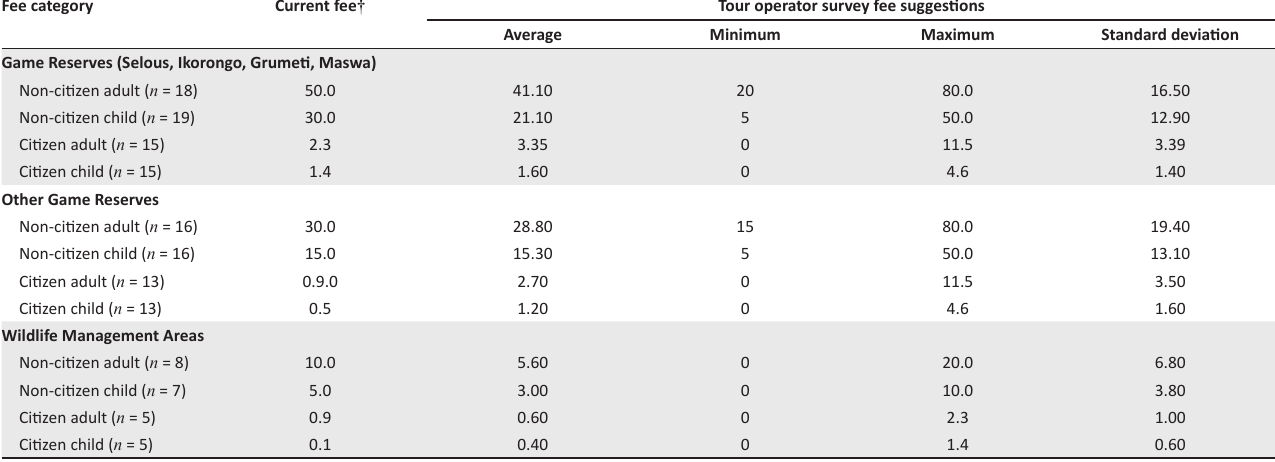
TABLE 3: Current and proposed entrance fees for Game Reserves and Wildlife Management Areas in USD equivalent values. Fee category Current fee † Tour operator survey fee suggestions Average Minimum Maximum Standard